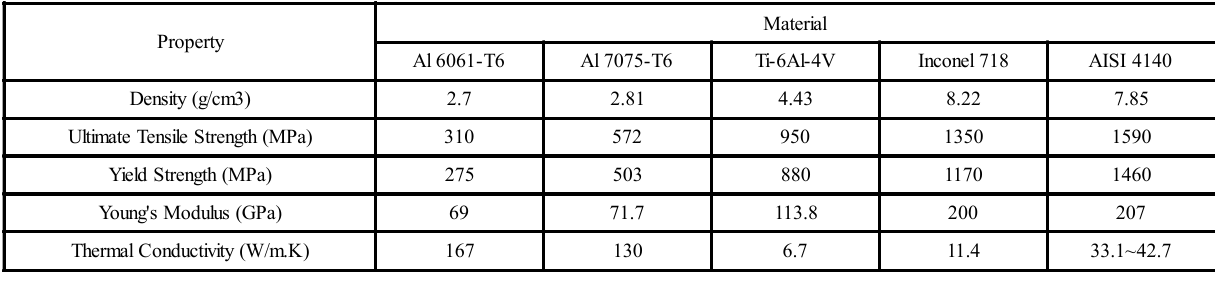
TABLE 5. RELEVANT MECHANICAL PROPERTIES OF AL 6061-T6 IN COMPARISON WITH OTHER ALLOYS OF RESEARCH INTEREST